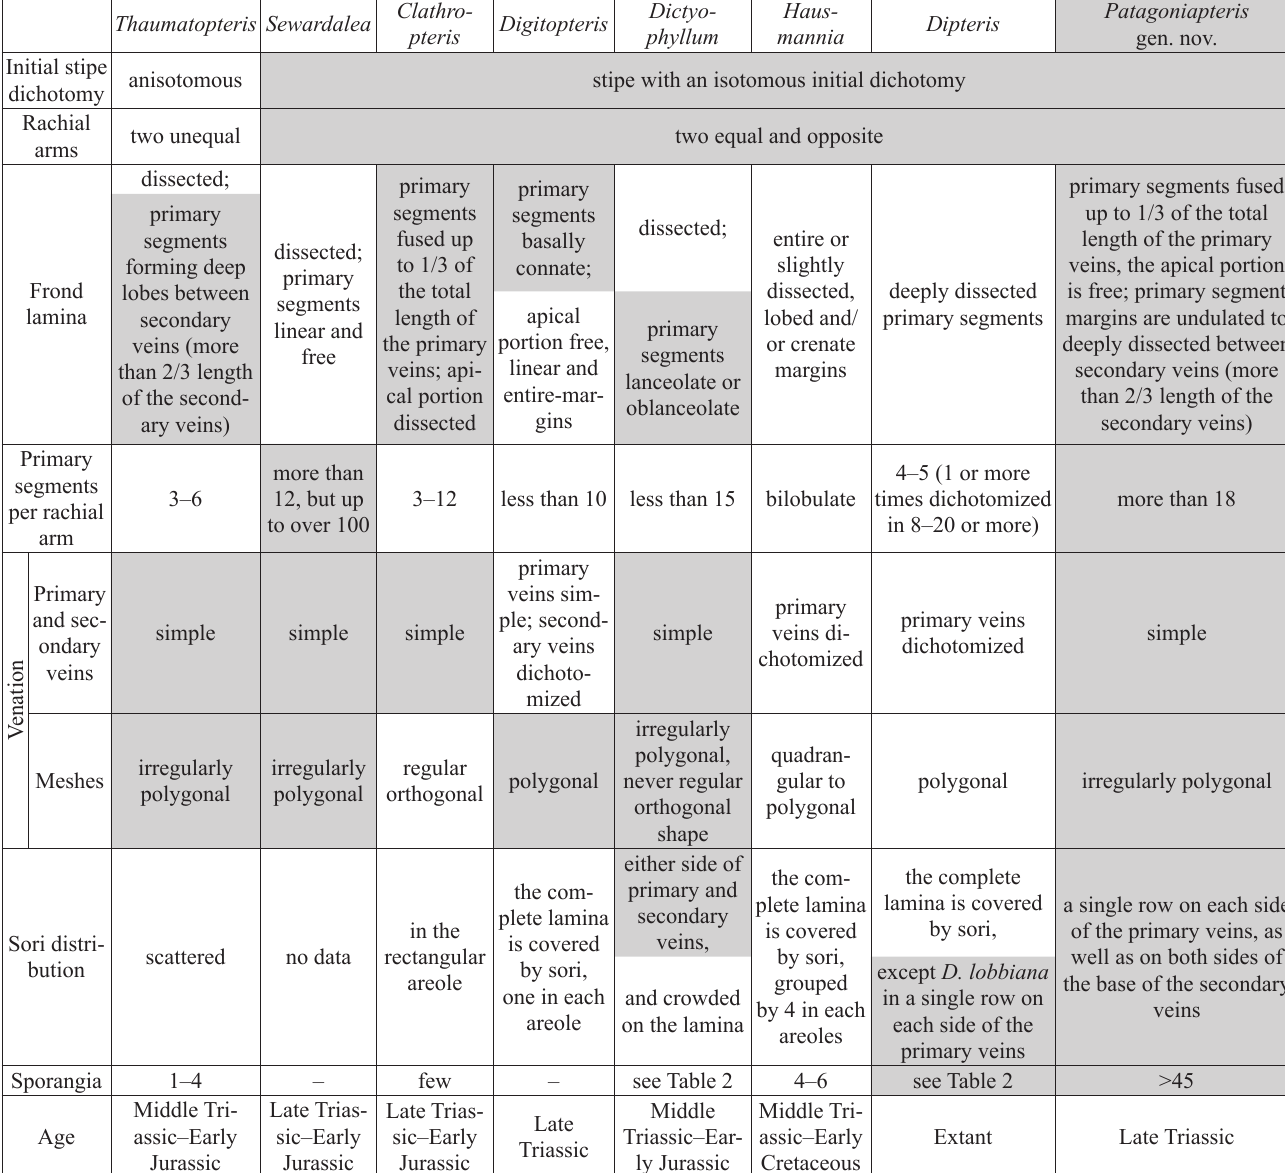
Table 1. Comparison of the morphology fronds and reproductive organ features between fossil and current genera of the Dipteridaceae (data taken from Seward and Dale 1901; Herbst 1992a, b; Smith et al. 2006; Choo and Escapa 2018; Zhang et al. 2013). Grey areas indicate features of different genera shared with the Paso Flores Formation specimens.